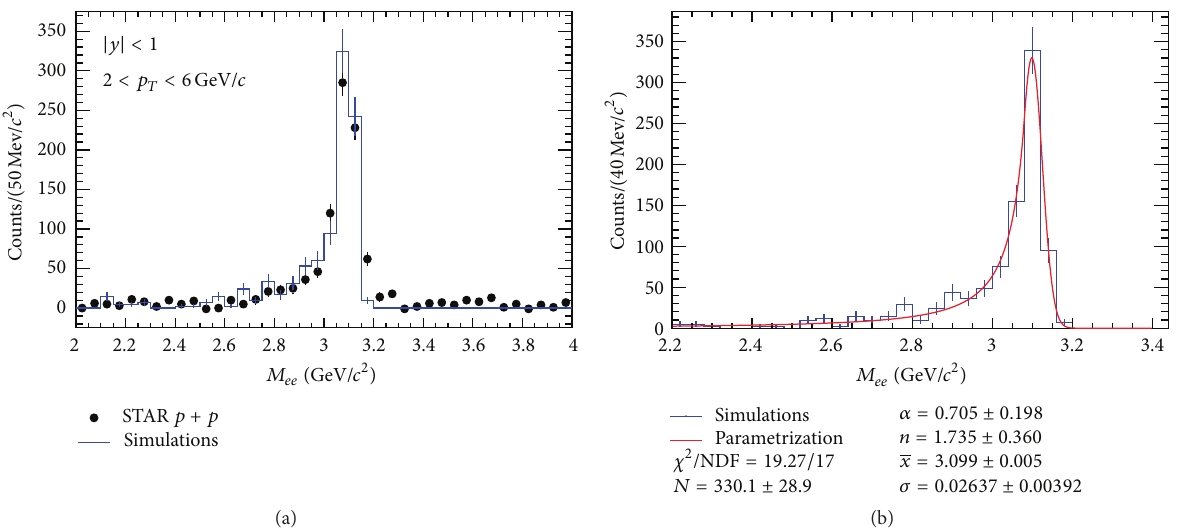
Figure 1: (a) 𝐽/𝜓 signal in 𝑝 + 𝑝 collisions at 200 GeV compared to the simulations. (b) Simulated 𝐽/𝜓 signal compared to a Crystal Ball function fitting used to account for the contribution of 𝐽/𝜓 → 𝑒 + 𝑒 − 𝛾 .